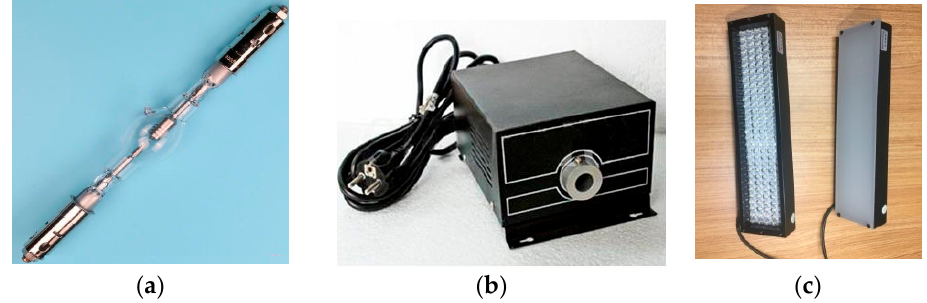
Figure 4. ( a ) Stroboscopic xenon lamps; ( b ) Halogen lamps; ( c ) Light-emitting diode (LED) lamps.